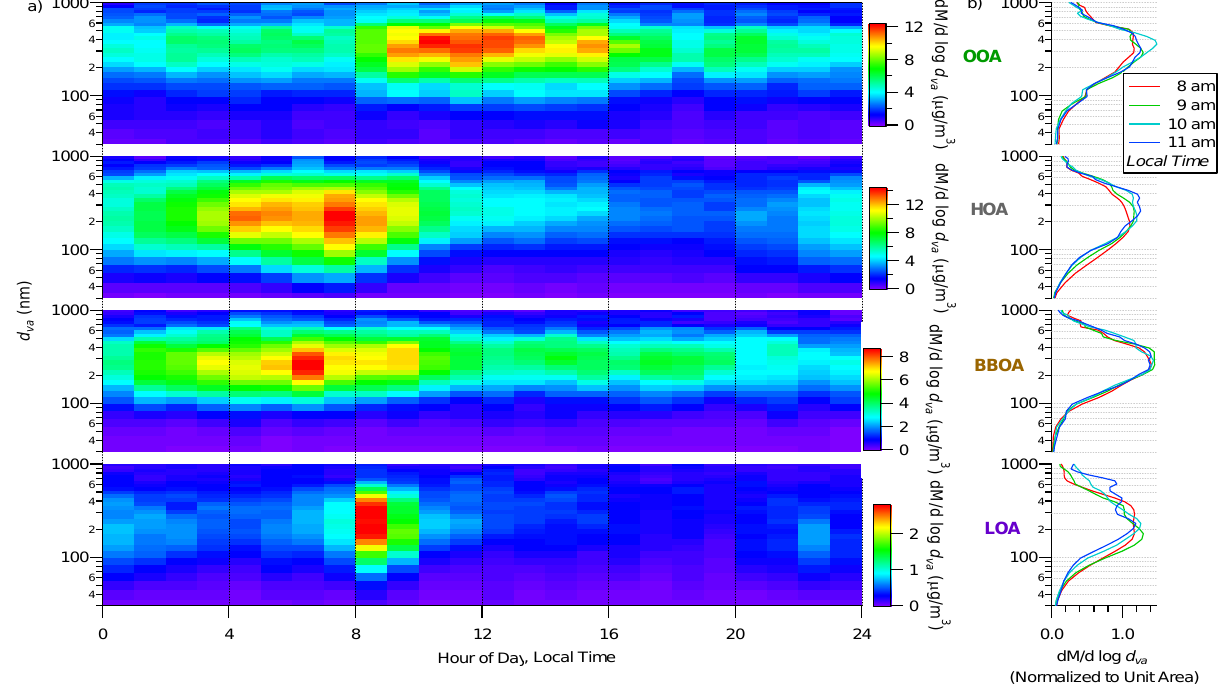
Fig. 9. Diurnal average size distributions of OOA, HOA, BBOA, and LOA from the best solution of the constrained vector-matrix model. (a) Image plots of diurnal average size distributions plotted (d M /dlog d va ), not normalized to unit area. (b) Size distributions from selected hours, normalized to unit area to compare the shapes of the